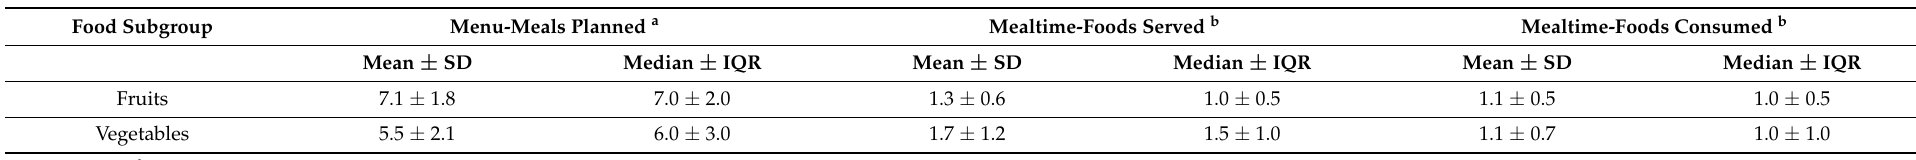
Table 4. Number of exposures to types of fruits and vegetables planned on menus and served and consumed during mealtime in Oklahoma Family Child Care Homes ( n = 51).